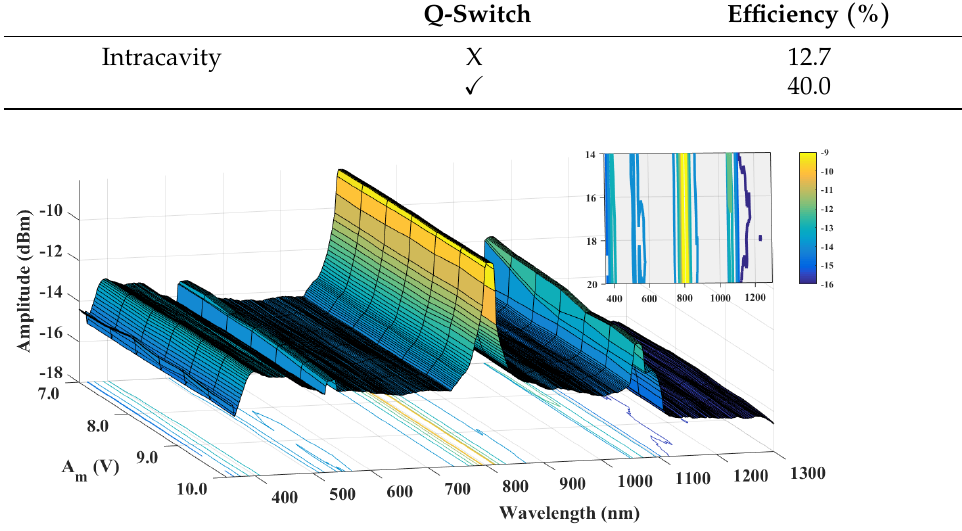
Figure 7. Surface of optical